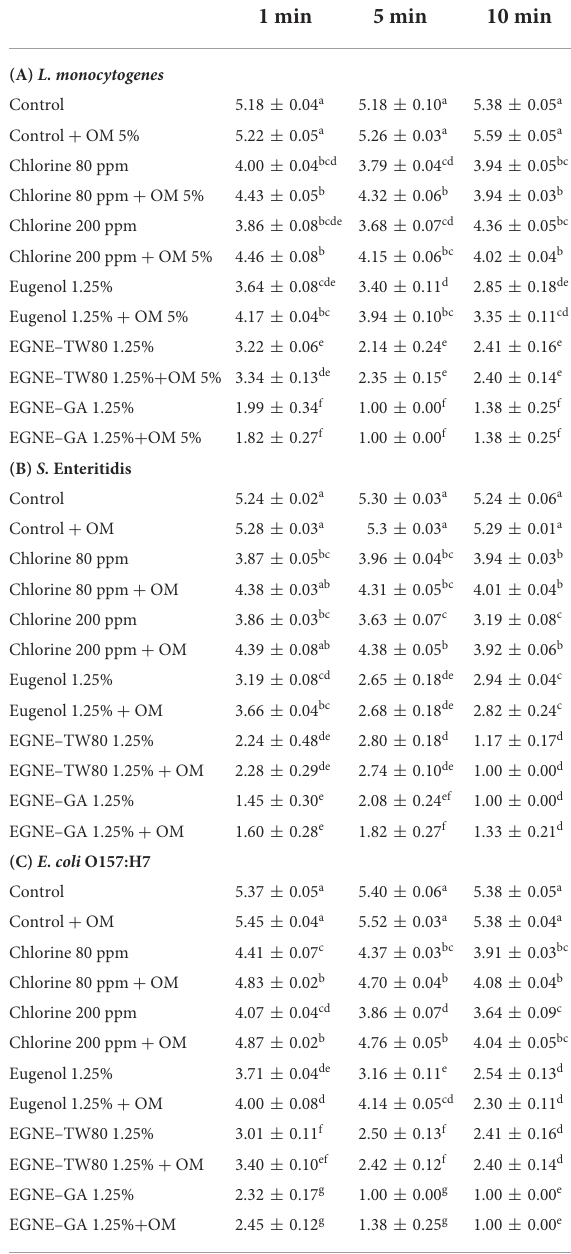
TABLE 4 Inactivation of L. monocytogenes , S. Enteritidis, or E. coli O157:H7 by eugenol or eugenol nanoemulsions in presence of 5% organic matter